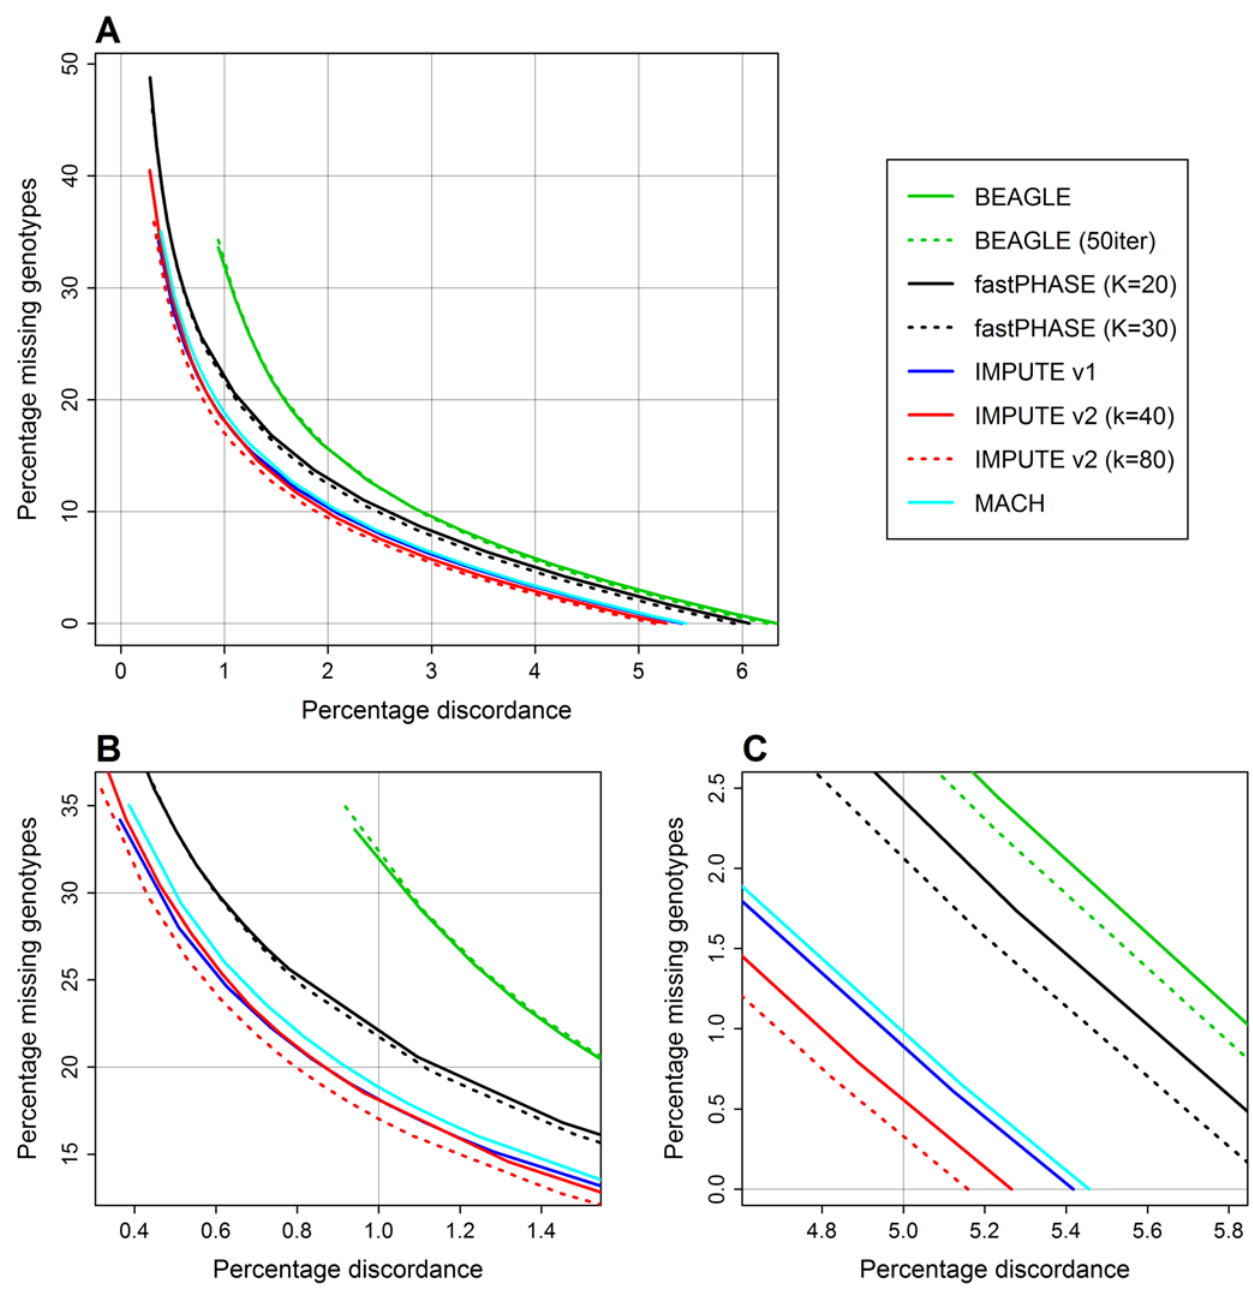
Figure 3. Percentage discordance versus percentage missing genotypes for Scenario A dataset. (A) Full range of results, corresponding to calling thresholds from 0.33 to 0.99. (B) Magnified results for calling thresholds near 0.99. (C) Magnified results for calling thresholds near